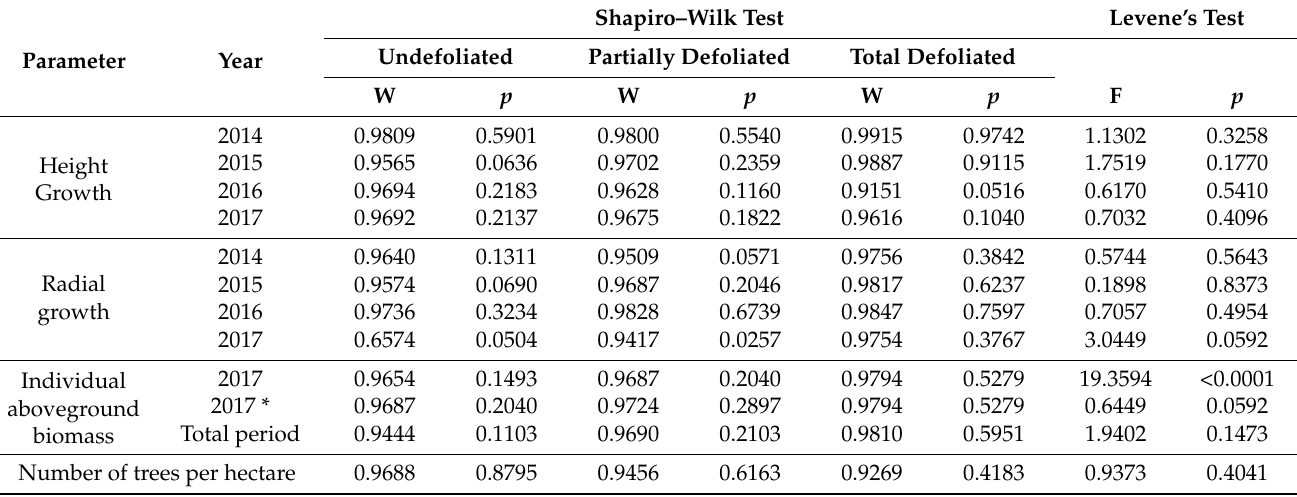
Table A1. Results of normality (Shapiro–Wilk test) and homogeneity (Levene’s test) tests for the growth parameters